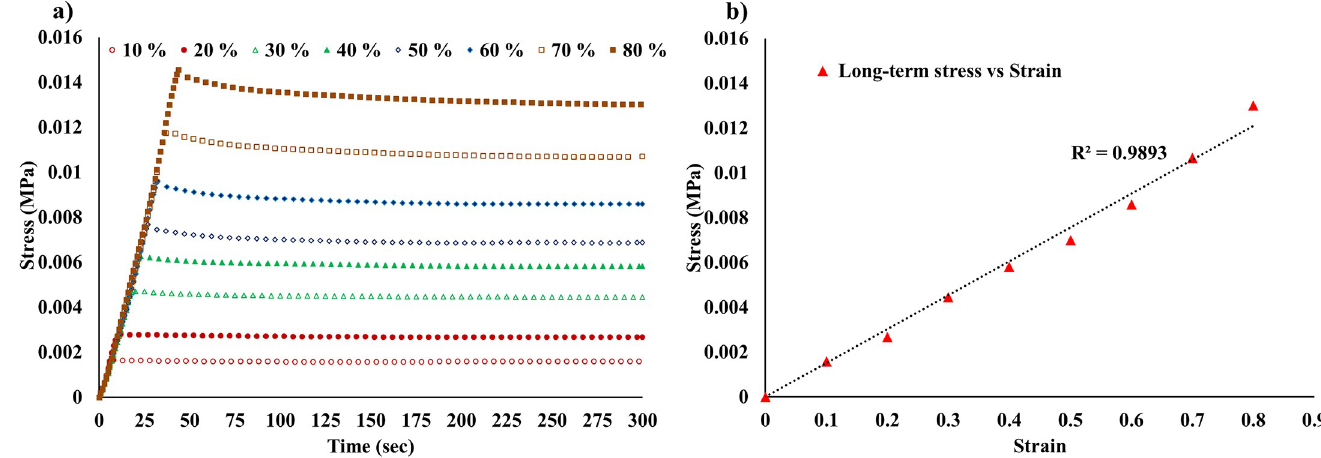
Fig 5. Simple shear relaxation test. a) Long-term shear stress at various strain magnitudes; b) the long-term shear stress-strain relationship. The high value of R 2 (0.9893) is an indication to the validity of considering the material as linear viscoelastic.